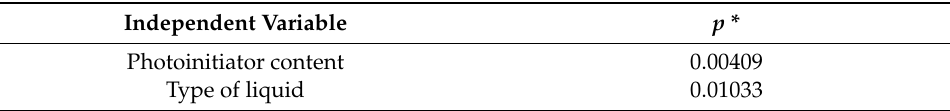
Figure 5. Sorption capacity of hydrogels in distilled water ( a ); SBF ( b ); Ringer liquid ( c ); and hemoglobin ( d ). (The study was performed in triplicate, n = 3). Table 2. Results of the statistical calculations via the ANOVA method.